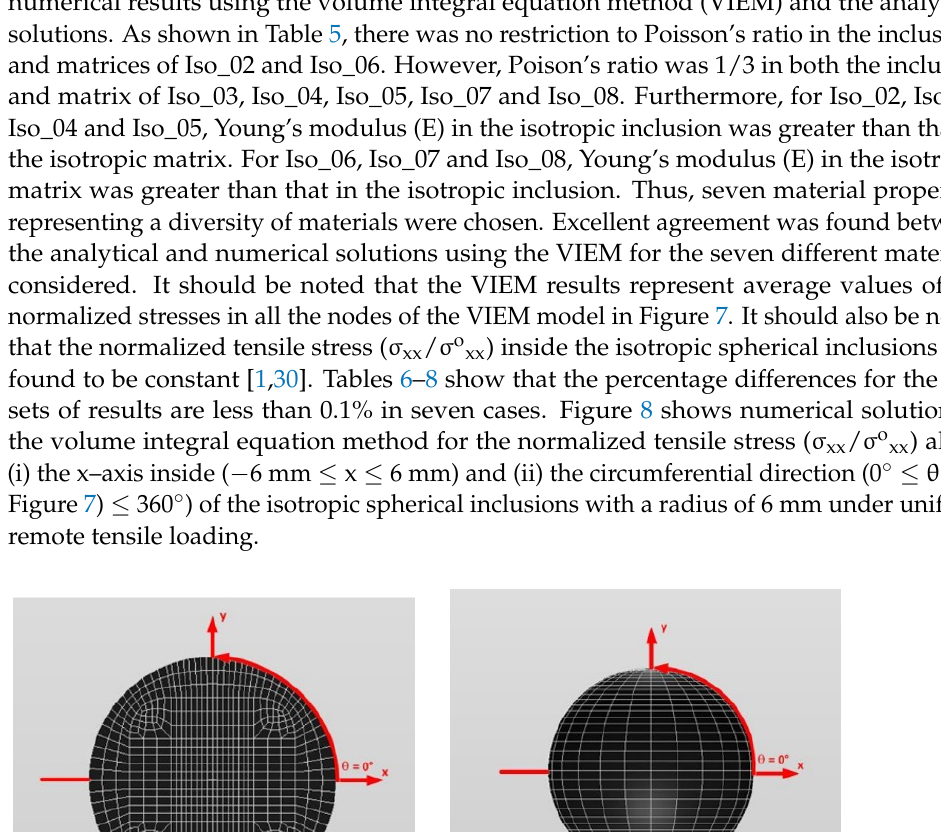
Table 6. Normalized tensile stress component ( σ xx / σ oxx ) within the isotropic spherical inclusion due to uniform remote tensile loading ( σ oxx ).